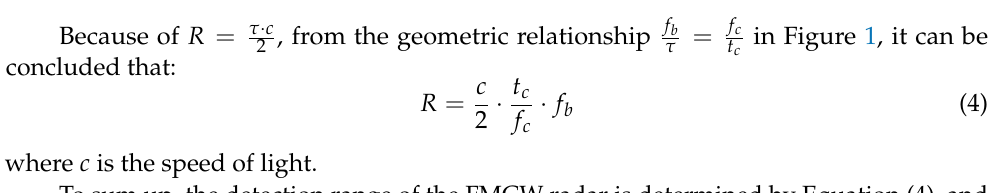
Figure 1. The curves of the sent signal frequency and the received signal frequency versus